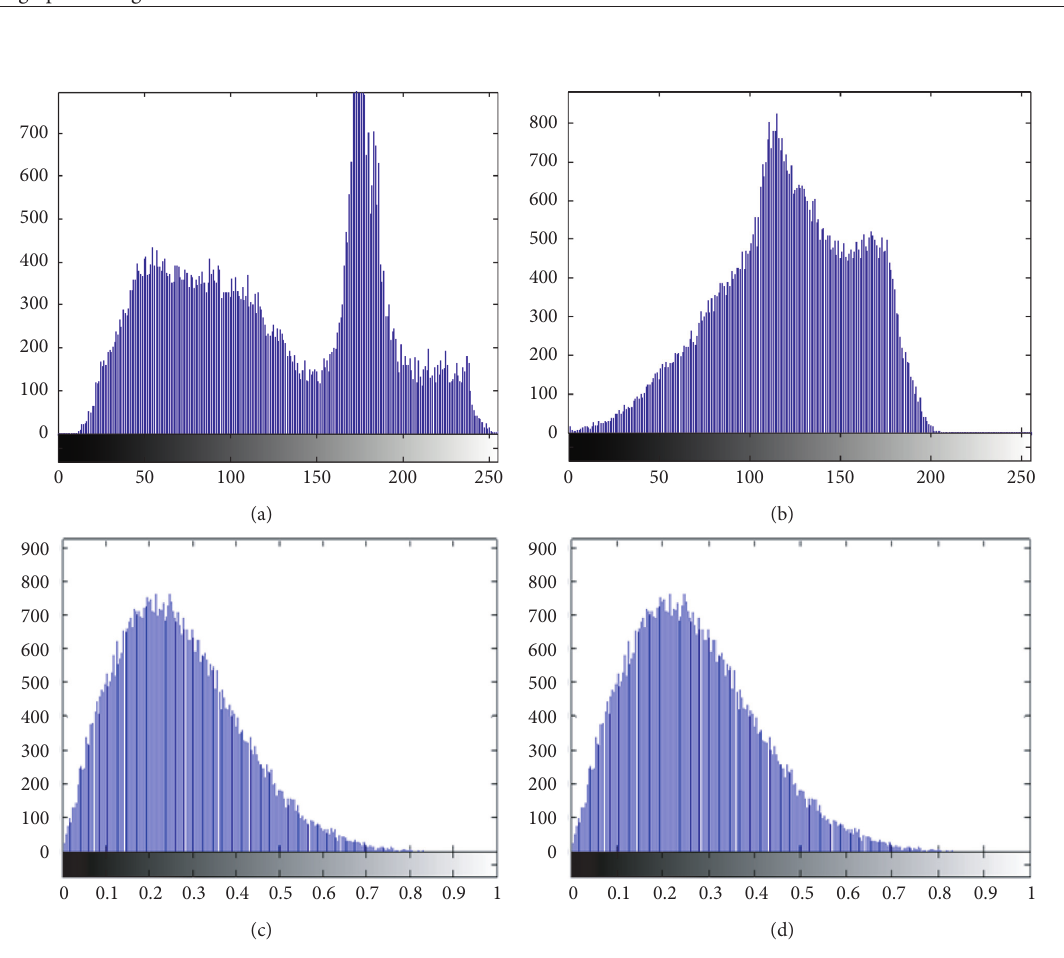
Figure 10: Histogram plots (a) of an input tree and (b) input image of a baboon; (c, d) encrypted images of tree and